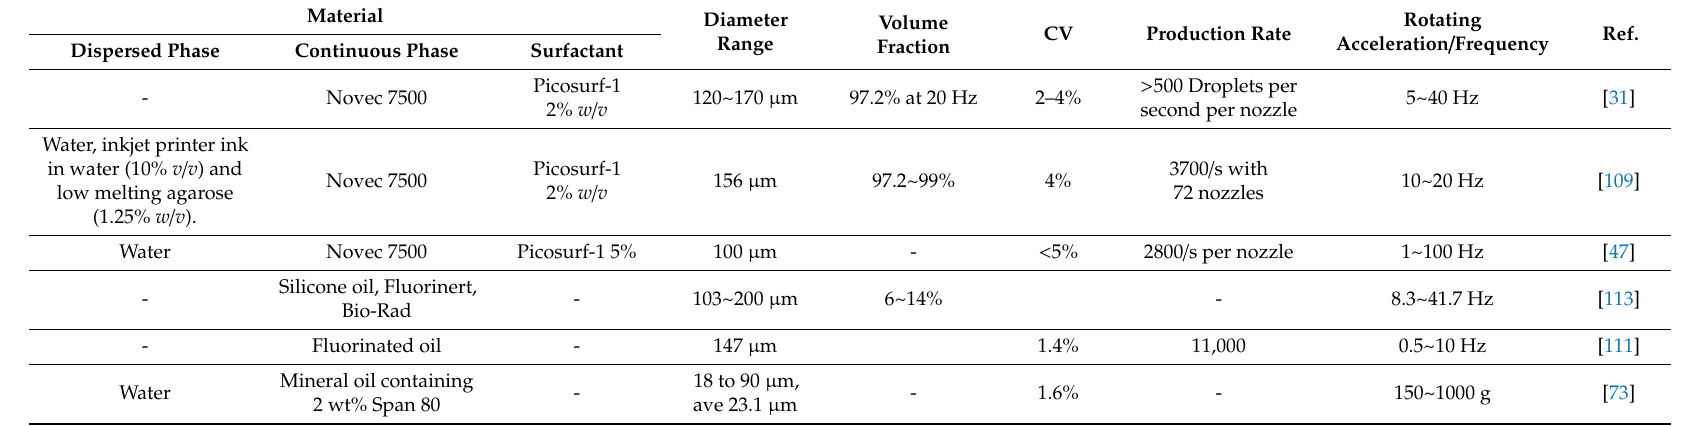
Table 1. Summary of reported step emulsification